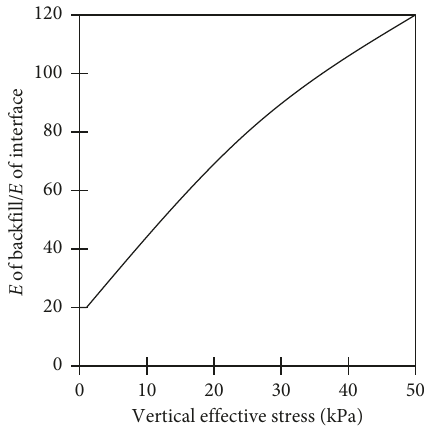
Figure 3: Young’s modulus of the backfill in the thin vertical elements along the walls adjusted as a function the vertical effective